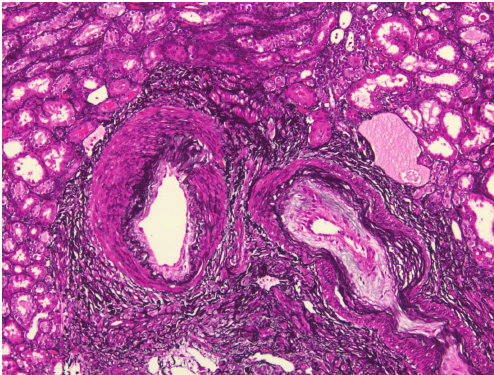
Figure 6: Prominent arterial adventitial fibrosis in a patient with scleroderma renal crisis. Note that the arteries also have mild intimal accumulation of myxoid material. (Methenamine silver stain; original magnification